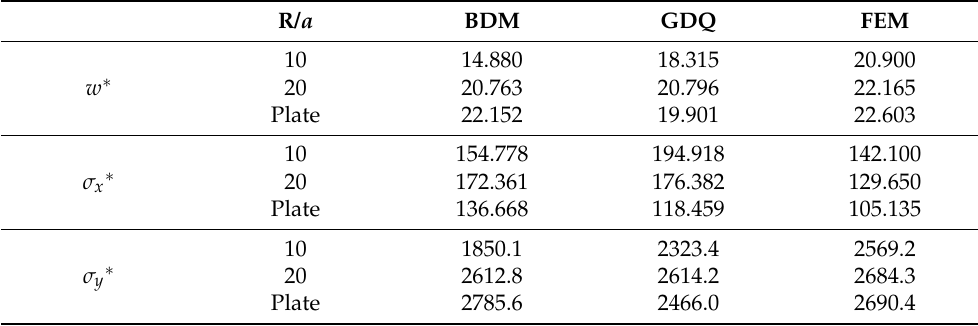
Table 2. Normalized central deflections of cross-ply [0 ◦ /90 ◦ ] laminated shells under uniform load. With SS–RS boundary conditions ( a / h = 20).